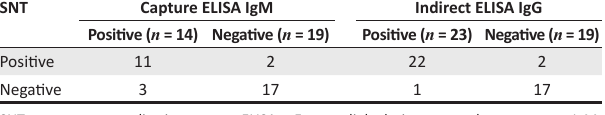
TABLE 2: Results obtained from selected Immunoglobulin M-positive and Immunoglobulin G-positive and negative sera using the serum neutralisation